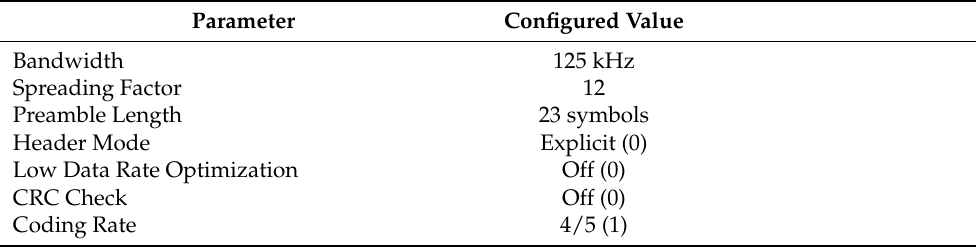
Figure 17. The state machine (energy model) of the RAK811 LoRa module modeled with IBM Rhapsody. Events are generated within methods or states of the RAK811 model. The tm(...) function indicates the use of timeouts after which a transition is executed. Attributes used as parameters for the tm(...) function are either calculated by the RAK811 model or defined by the specification of the wireless communication protocol. All transitions are expected to be instantaneous with their tagged values current and execTime set to (0, mA) and (0, ms). Table 2. Parameters of the RAK Wireless RAK811 hardware model to calculate the TX window size. A more detailed explanation of the parameters can be found in